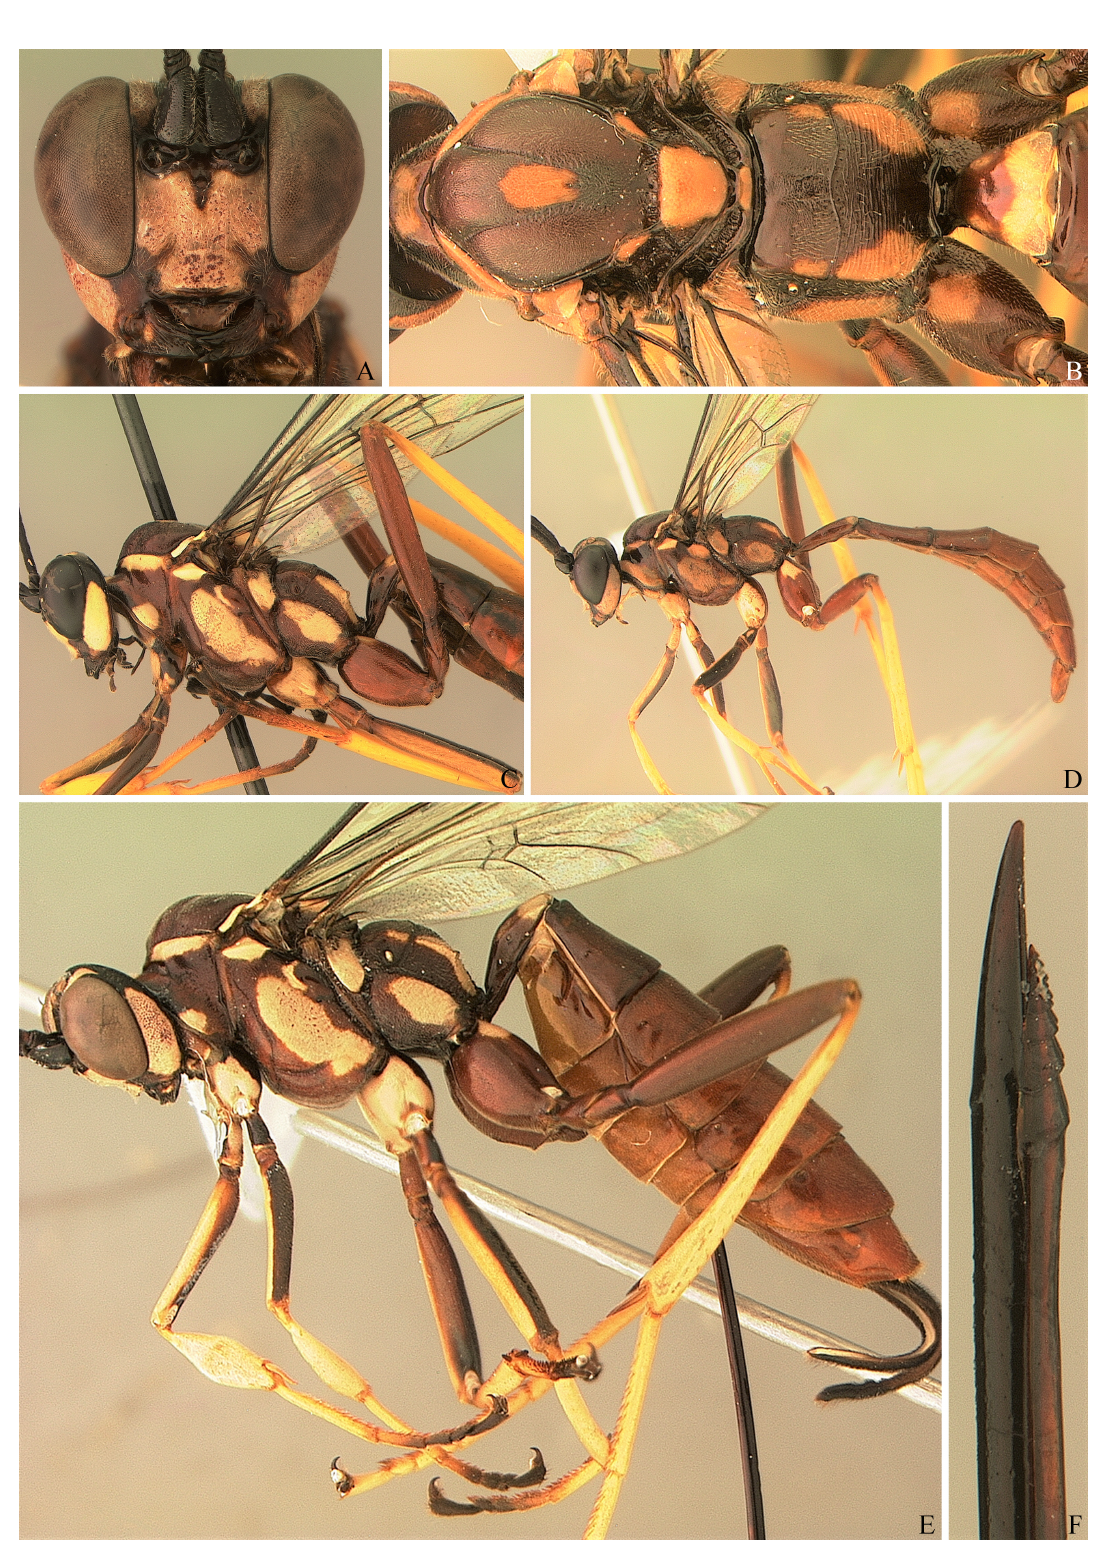
Fig. 14. Distictus terrosus sp. nov. A . Head, frontal view; holotype (UFES45302). B . Mesosoma + first tergite, dorsal view; holotype. C . Habitus of female paratype (CNCI). D . Habitus of male paratype (UFES45297). E . Habitus of holotype. F . Apex of ovipositor, left